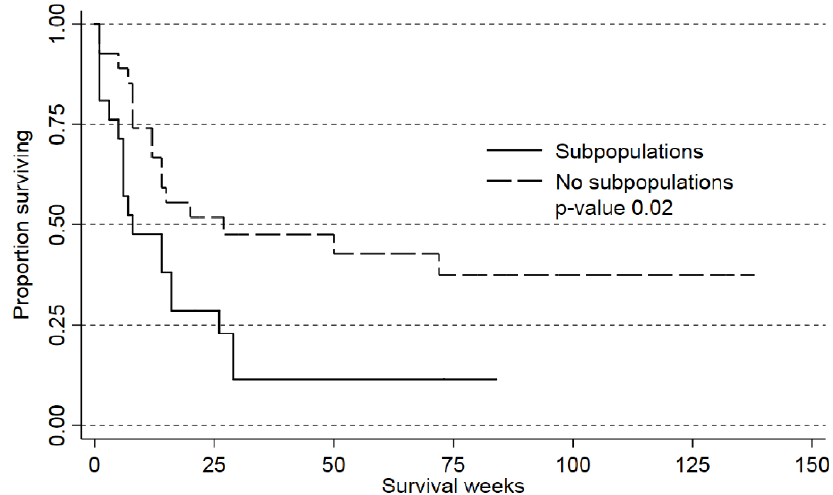
Figure 3. Overall survival of patients with (17 patients) and without (27 patients) clonal